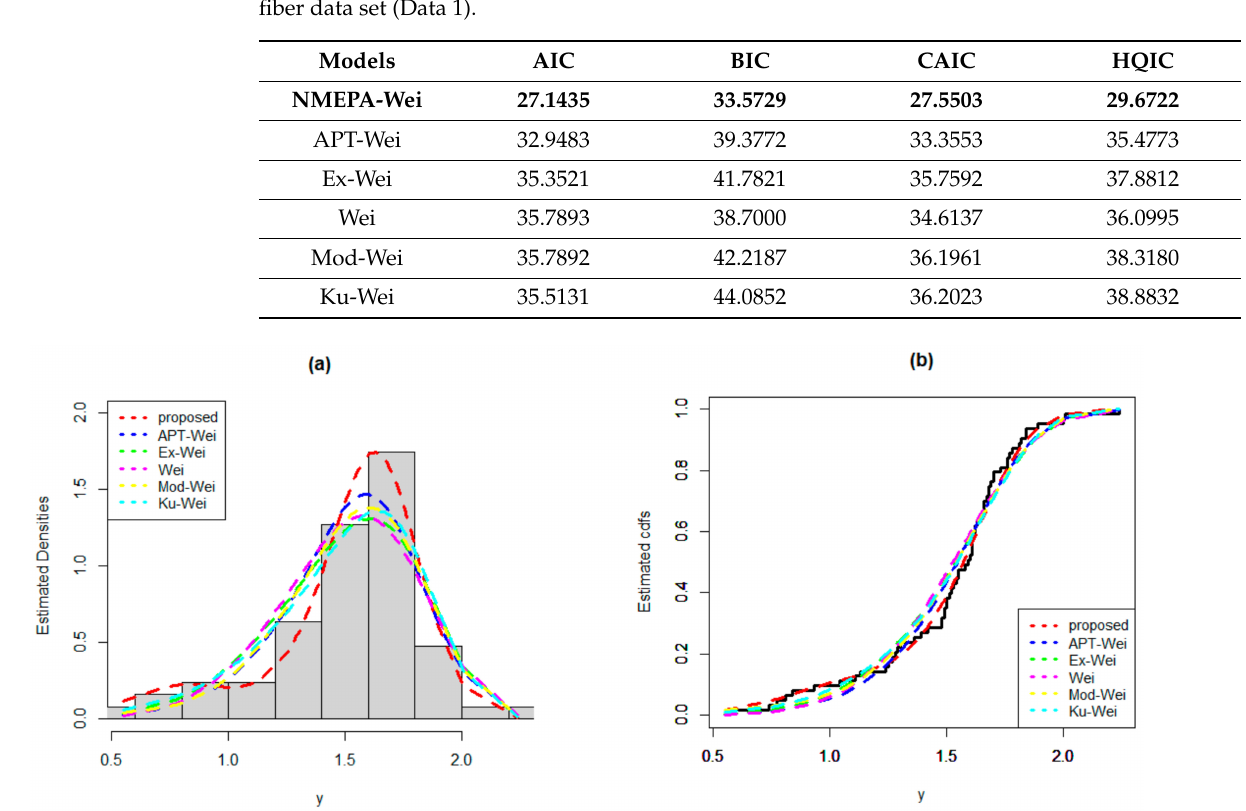
Figure 12. Plots of ( a ) estimated PDFs, and ( b ) estimated CDFs of competitive models for Data 1.